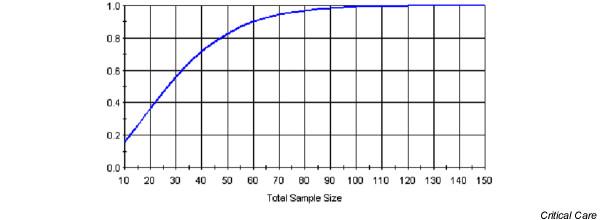
Power as a function of sample size.